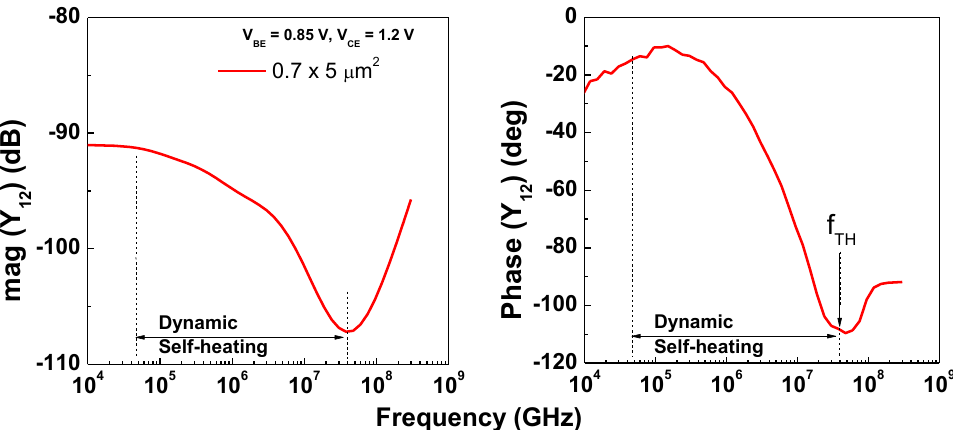
Figure 8. Y 12 parameter versus frequency showing the zone where dynamic self-heating activates.